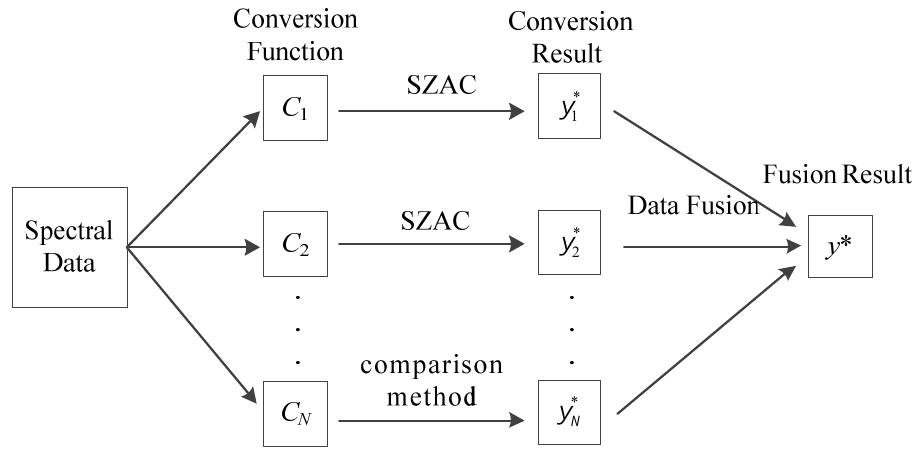
Figure 2. Schematic diagram of data conversion and fusion processing.